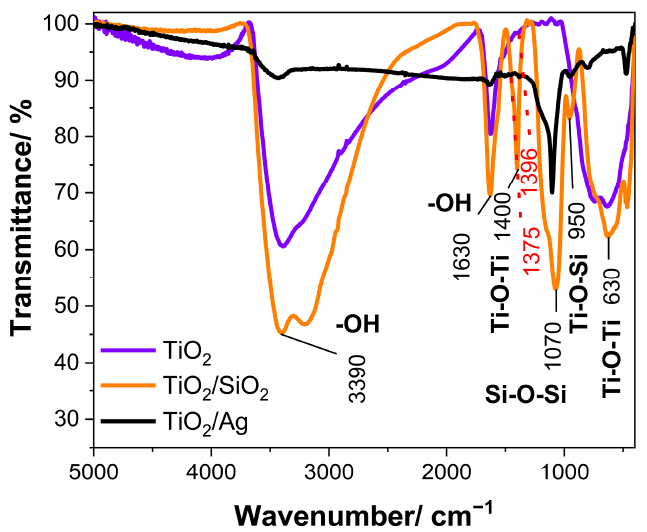
Figure 6. Fourier-Transform Infrared spectra for TiO 2 NPs, TiO 2 /SiO 2, and TiO 2 /Ag (the change in vibration of the TiO 2 lattice from 1396 to 1375 cm − 1 is marked in red).